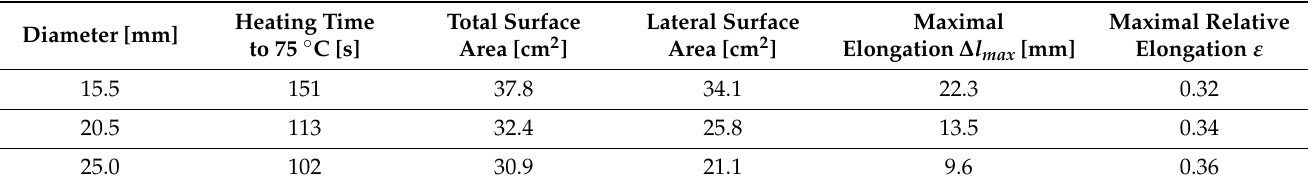
Figure 11. Relative elongation ε of tube actuators with equal volumes of composite and different diameters.